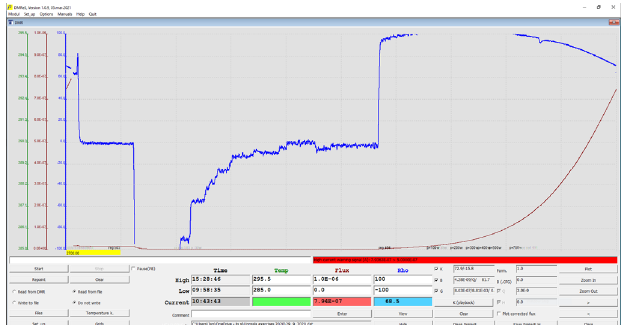
Figure 2 Screenshot of the Digital Reactivity Meter displaying data recorded during an approach criticality experiment by students of Uppsala University. The graph on the top displays the neutron flux in red, fuel temperature in green and the calculated reactivity in blue. The controls on the bottom control the plotting range, data logging and processing of the flux signal.